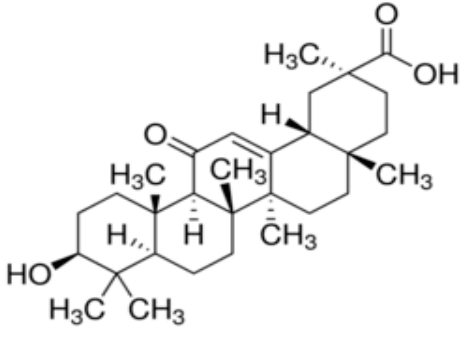
Figure 1. Chemical structure of GA.